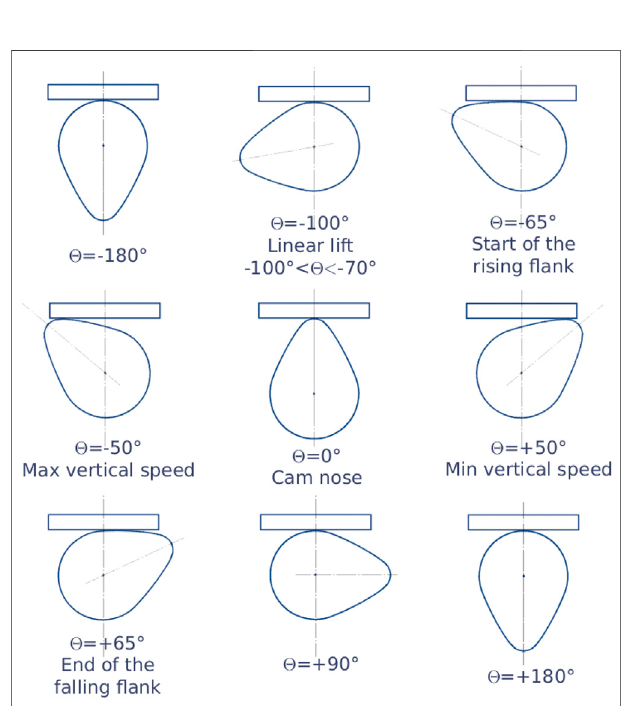
FIGURE 6 | Signi fi cant positions during the clockwise rotation of the spline